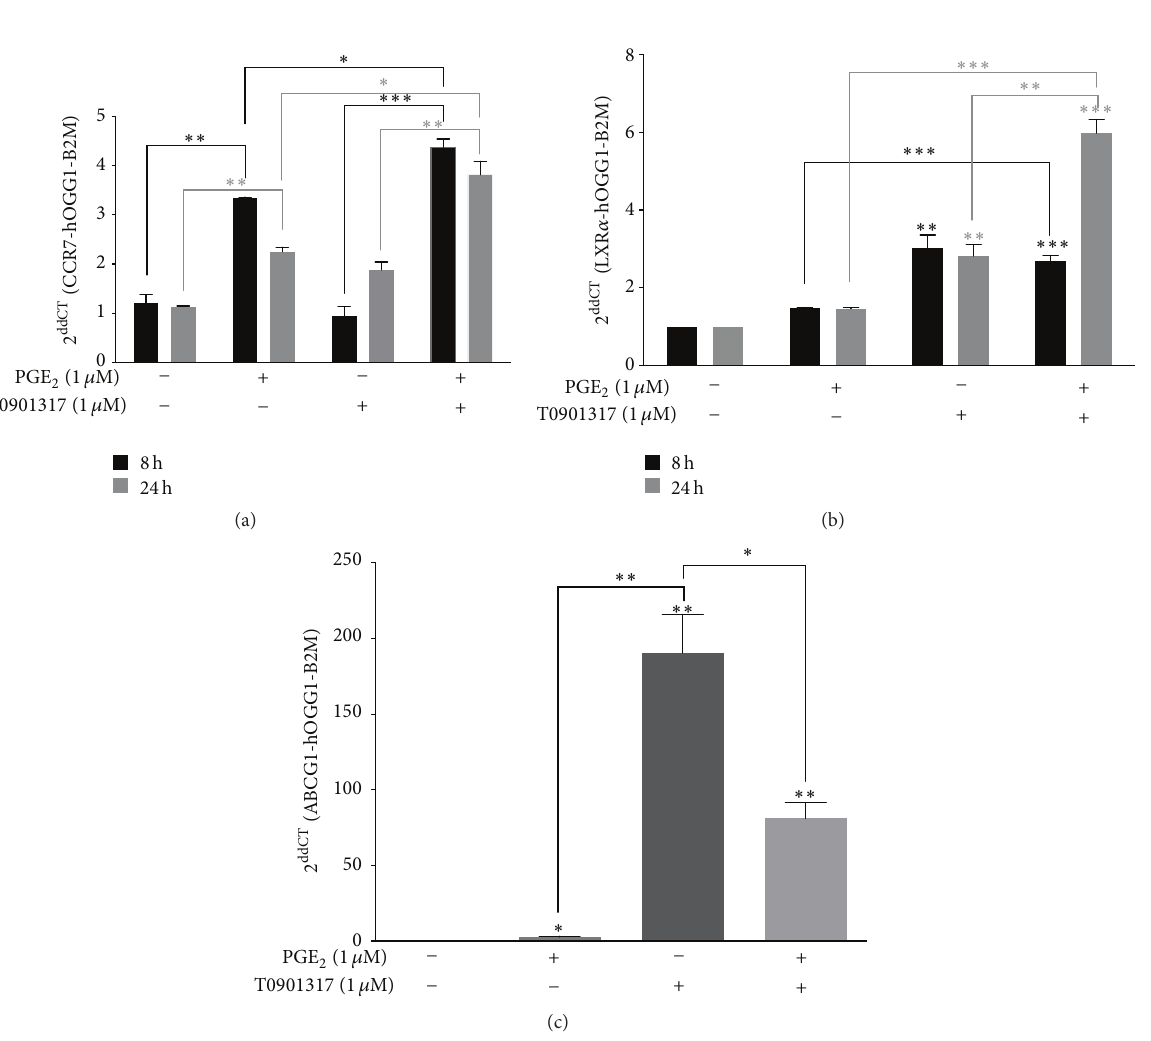
Figure 1: Effects of PGE 2 and T0901317 on CCR7 , ABCG1 , and LXR 𝛼 transcription in MM-1 cells. MM-1 cells were stimulated for 8h and 24 h with 1 𝜇 M PGE 2 and 1 𝜇 M T0901317. Total RNA was extracted and examined using real-time quantitative PCR to detect CCR7 (a), ABCG1 (b), and LXR 𝛼 (c) mRNA levels. Data represent mean ± standard deviation (SD) of three independent experiments. ∗ 𝑝 < 0.05 , ∗∗ 𝑝 < 0.01 , and ∗∗∗ 𝑝 < 0.001